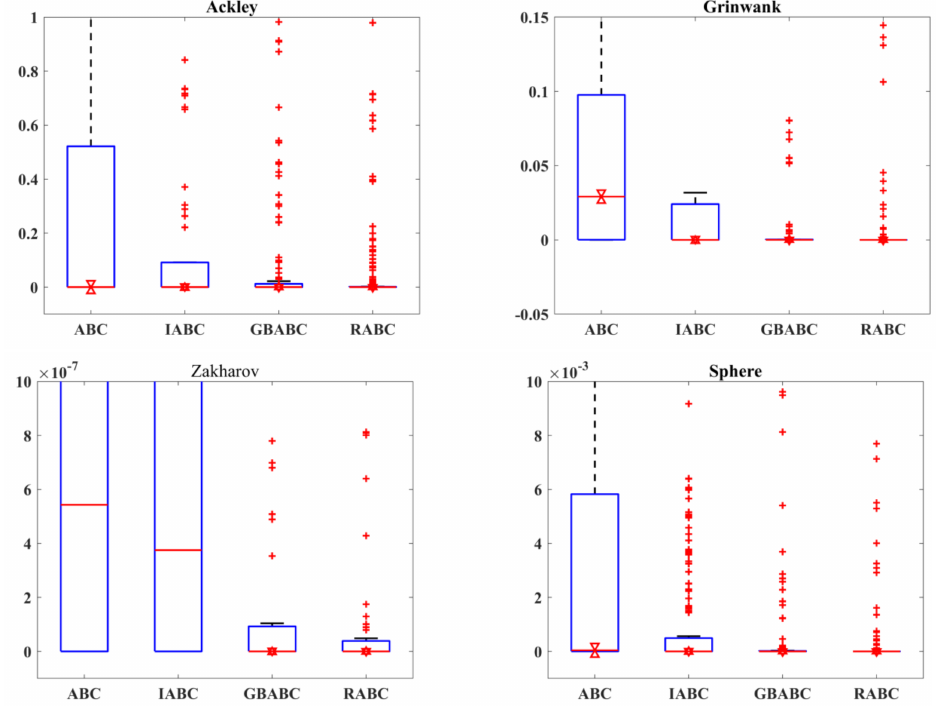
Figure 5. Box plot obtained by the ABC, IABC, GBABC, and RABC